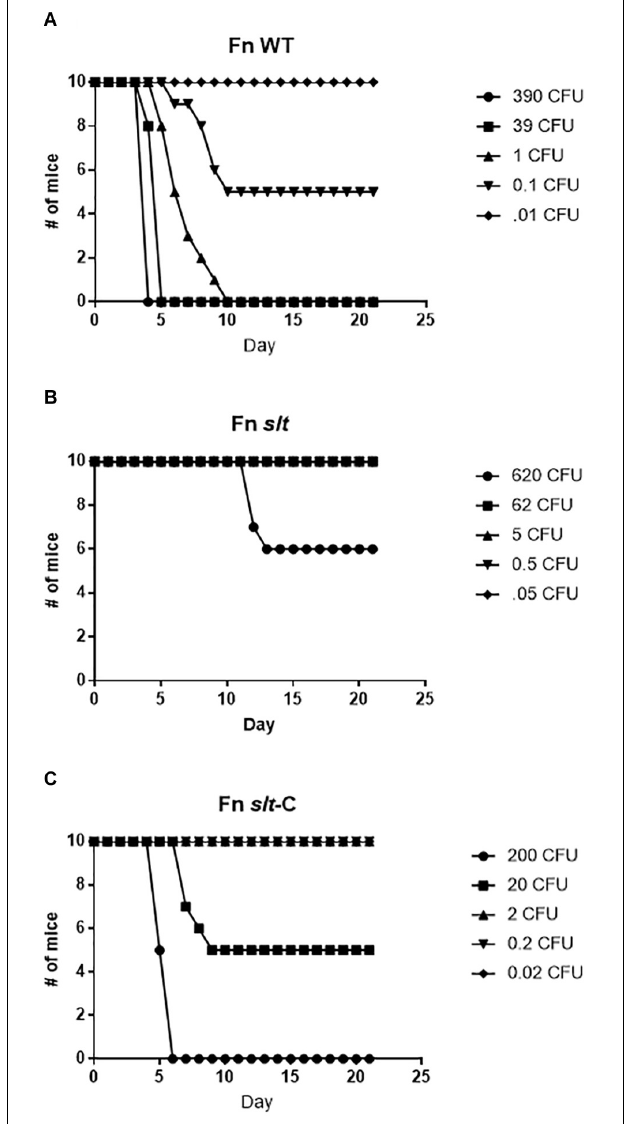
FIGURE 7 | Fn slt is attenuated during intranasal infection. Groups of BALB/c mice ( n = 10) were challenged with 5 doses of (A) Fn WT, (B) Fn slt , and (C) Fn slt -C strains, and monitored for 21 days. LD 50 values from these experiments are included in Table 2 .